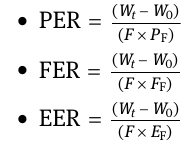
Vegetables 1,475.49 ± 304.38